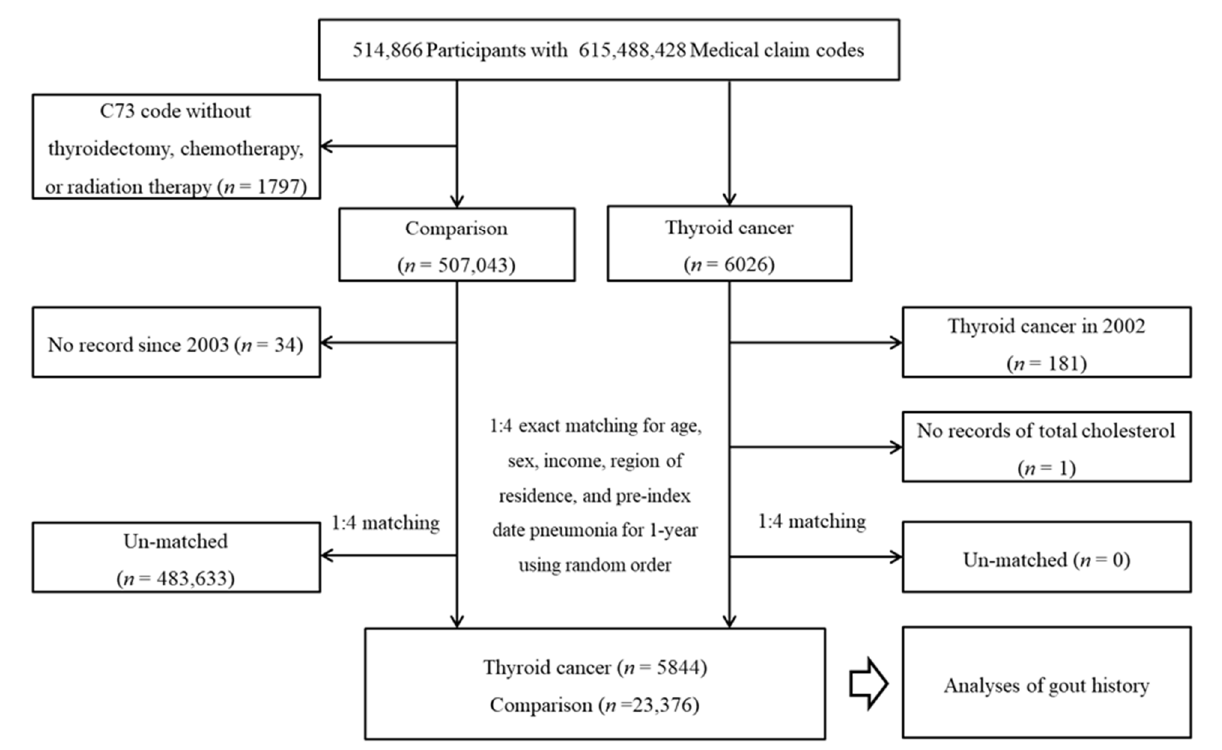
Figure 1. A schematic illustration of the participant selection process used in the present study. Of a total of 514,866 participants, 5844 thyroid cancer participants and 23,376 comparison participants were matched at a 1:4 ratio according to age, sex, income, and region of residence.